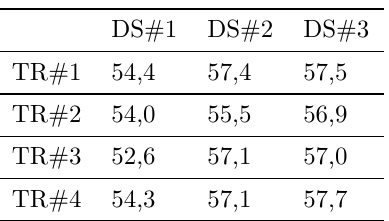
Table 4. Results for DS: